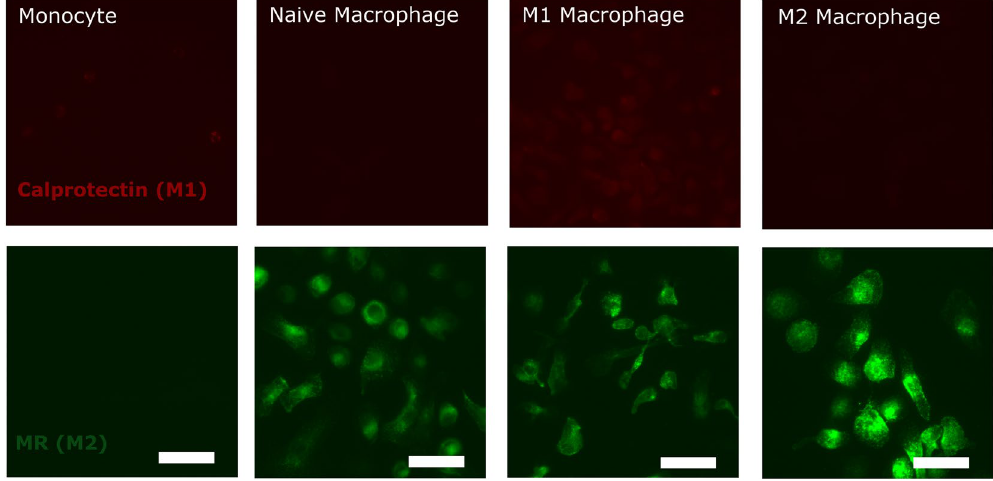
Figure 1. Fluorescent images of monocytes and macrophages stained for calprotectin (27E10 antigen, red, A – D ), and mannose receptor (MR, green, E – H ). Scale bar = 25 µ m. Representative images from 6 independent biological samples (donors) are